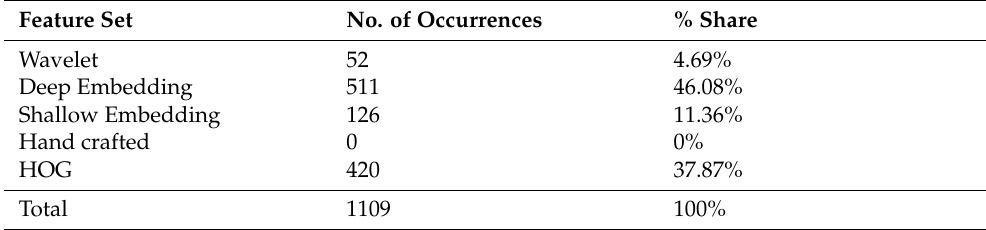
Table 4. Feature importance for the feature set that was chosen by the XGBoost algorithm. For each feature extraction method number of occurrences and % share of features qualified to the model as